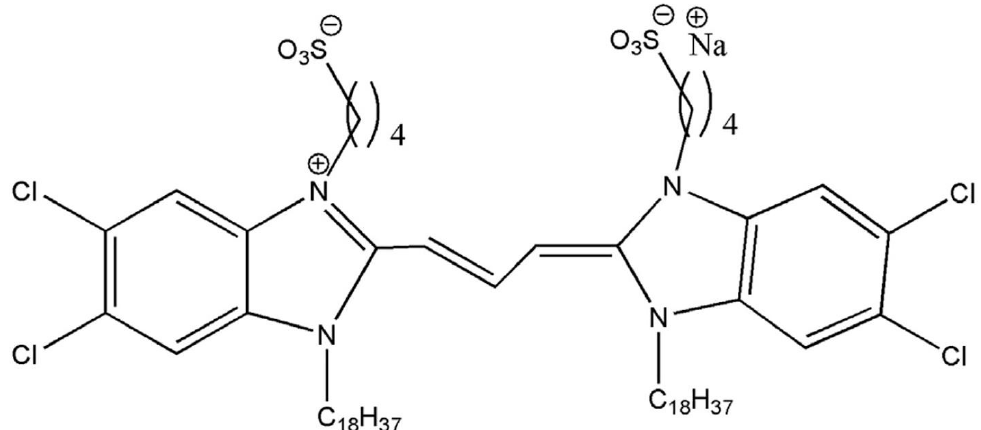
Figure 10. Structure of the dye C18S4 [6] investigated experimentally in [86]. The length of the main optical chromophore, the polymethine chain [38], is defined as the distance L between nitrogen atoms N and N with L = 6 d , where d designates roughly equal the C − C bond lengths of methine groups (cf. Figure 3), d = 0.14 nm